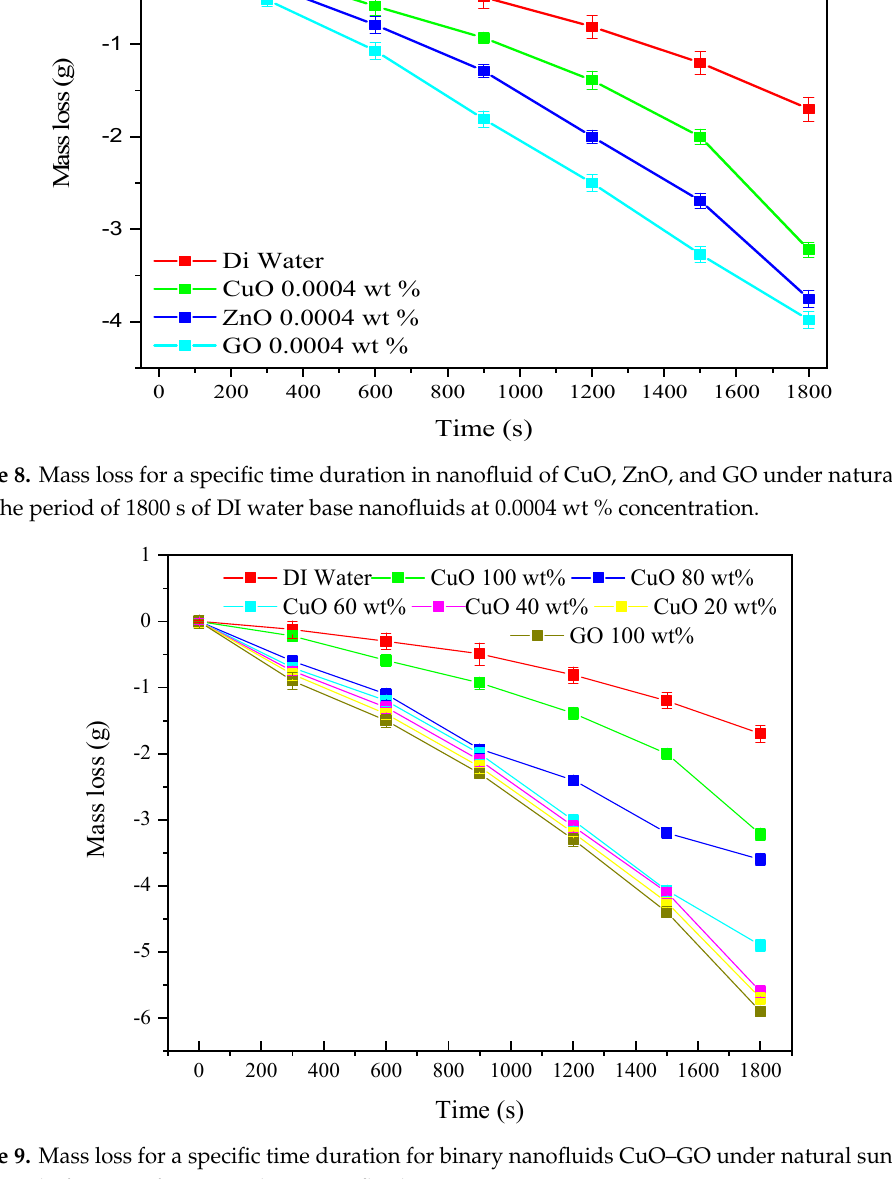
Figure 10. Mass loss for a specific time duration for binary nanofluids ZnO–GO under a natural sun over the period of 1800 s of DI water base nanofluids at 0.0004 wt % concentrations. 3.4. Photothermal Efficiency Photothermal efficiency (PTE) is the ratio between the internal energy increase of fluid to the total incident solar radiation [46]. ɳ (cid:2172)(cid:2176)(cid:2161) = ∫ (cid:2777)(cid:2202) ((cid:2159) (cid:2179) (cid:2195) (cid:2179) ). (cid:2212)(cid:2176). (cid:2186)(cid:2202) + ∫ (cid:2777)(cid:2202) (cid:2168) (cid:2178) (cid:2195) (cid:2194)(cid:2197)(cid:2201)(cid:2201) . (cid:2186)(cid:2202) ∫ (cid:2777)(cid:2202) (cid:2165). (cid:2157). (cid:2186)(cid:2202) (1) where C W defines the specific heat capacity of water measured in (J/kgK); L v is the latent heat of vaporization (J/kg) at a pressure of 1 bar; m loss is the mass loss (mloss = minitial/t) of nanofluid in time